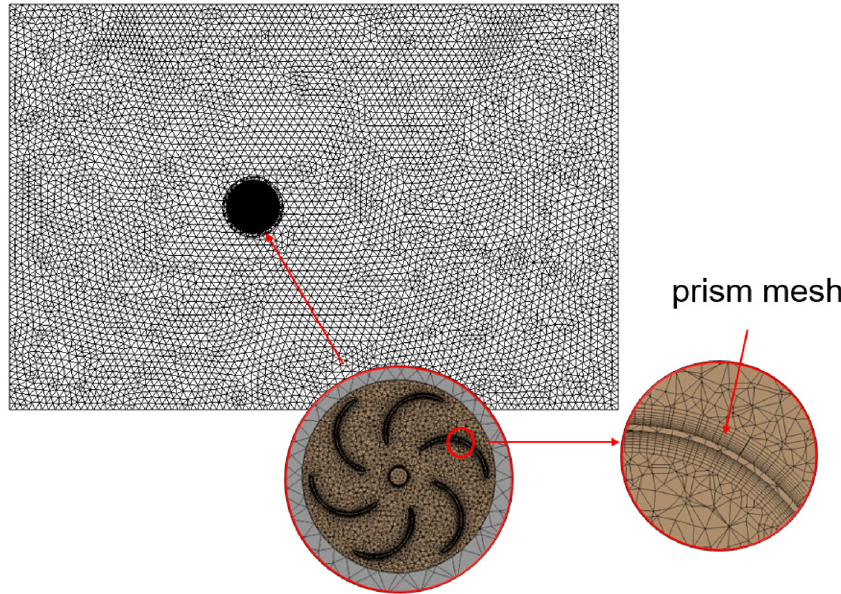
Figure 9. Computational domain mesh details (prism mesh). Table 2. Variations in C pmax relative to different amounts of